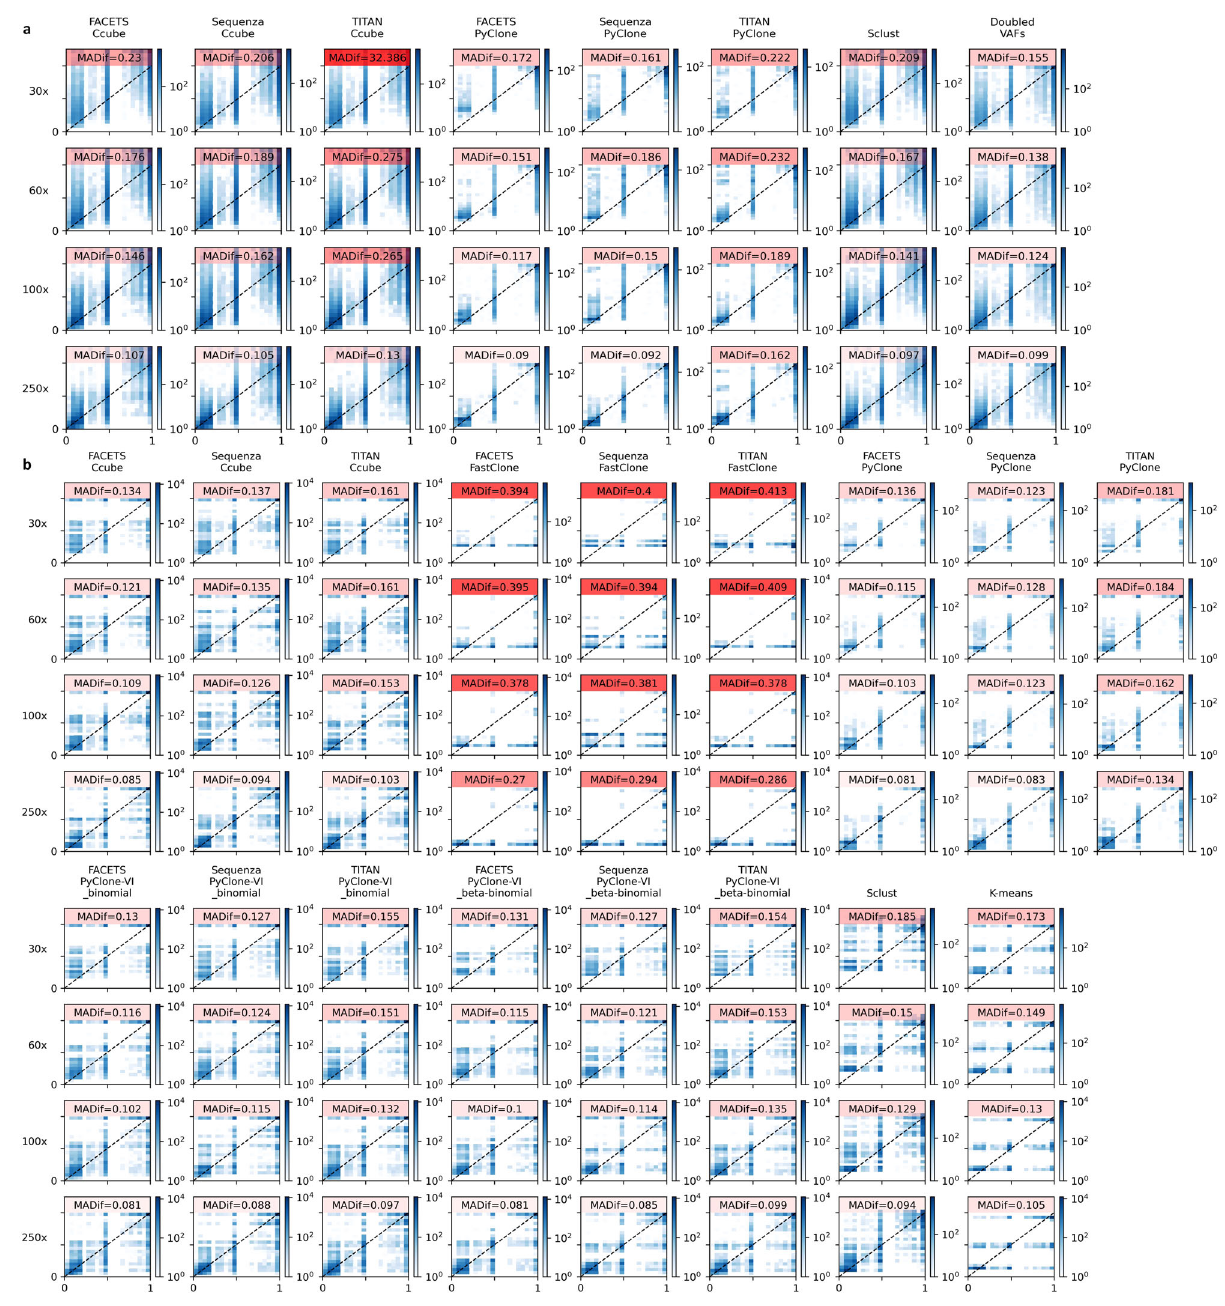
Fig. 5 True CCF ( x -axis) versus predicted CCF ( y -axis) from subclonal deconvolution pipelines applied to tumours sequenced to different depths. Plots are separated by predictions based on a non-clustered CCFs, for which ‘ Doubled VAFs ’ represents the simplistic baseline from which to assess performance; and b clustered CCFs, for which K-means provides the simplistic baseline. N = 18 samples at each depth. MADif: weighted mean absolute difference of true vs. predicted CCFs with the depths of colour corresponding to the value. CCF cancer cell fraction, VAF variant allele frequency. Source data are provided as a Source data fi